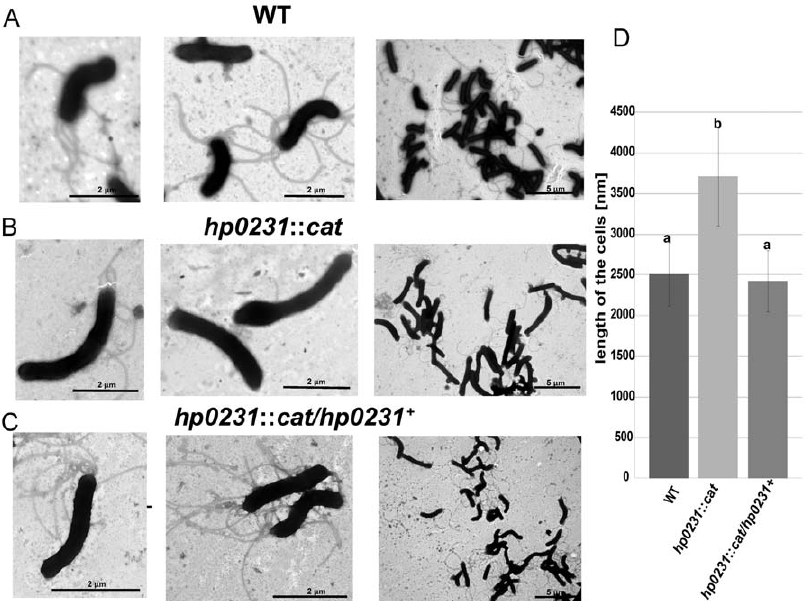
Figure 4. Comparison of H.pylori N6 cells (wt, hp0231::cat and hp0231::cat complemented intrans by puWM397 (pHel2/ hp0231 ) morphology by transmission electron microscopy (TEM). A) WT, B) hp0231 :: cat and C) hp0231 :: cat/hp0231 + ( hp0231 :: cat complemented in trans by wild type copy of hp0231 ). D) The diagram illustrates mean lengths and standard deviations of 100 bacterial cells in nm. Error bars with the different letters indicate a significant difference (p , 0.01) in length between the H. pylori N6 wt cells and the mutant strain, and the mutant and the complementant strain (Welch ANOVA followed by post hoc Tukey’s test).